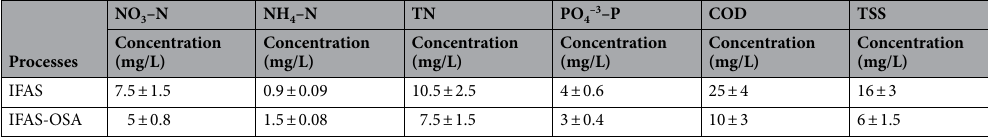
Table 2. The average steady-state concentrations and standard deviations of the NH 4+ –N, NO 3 –N, TN, PO 4–3 –P, COD and TSS measurements in the effluents of the IFAS and IFAS-OSA.